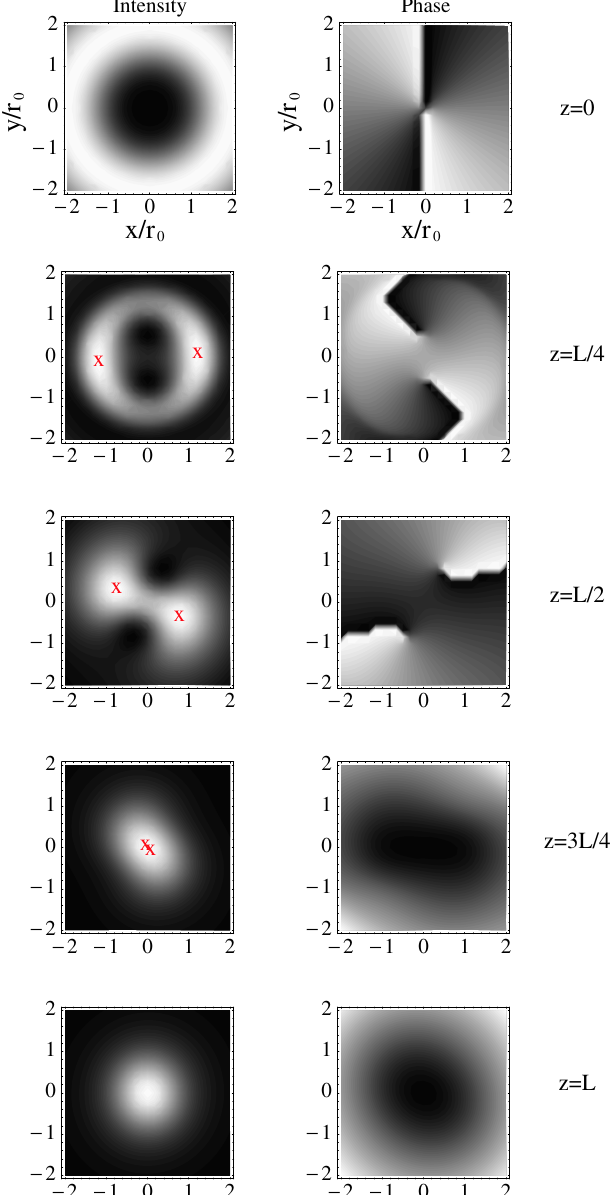
FIG. 5. (Color) Intensity and phase along the undulator for an l (cid:3) 2 seed on a cold beam. The axial phase singularity is broken into two l (cid:3) 1 vortices as the fundamental